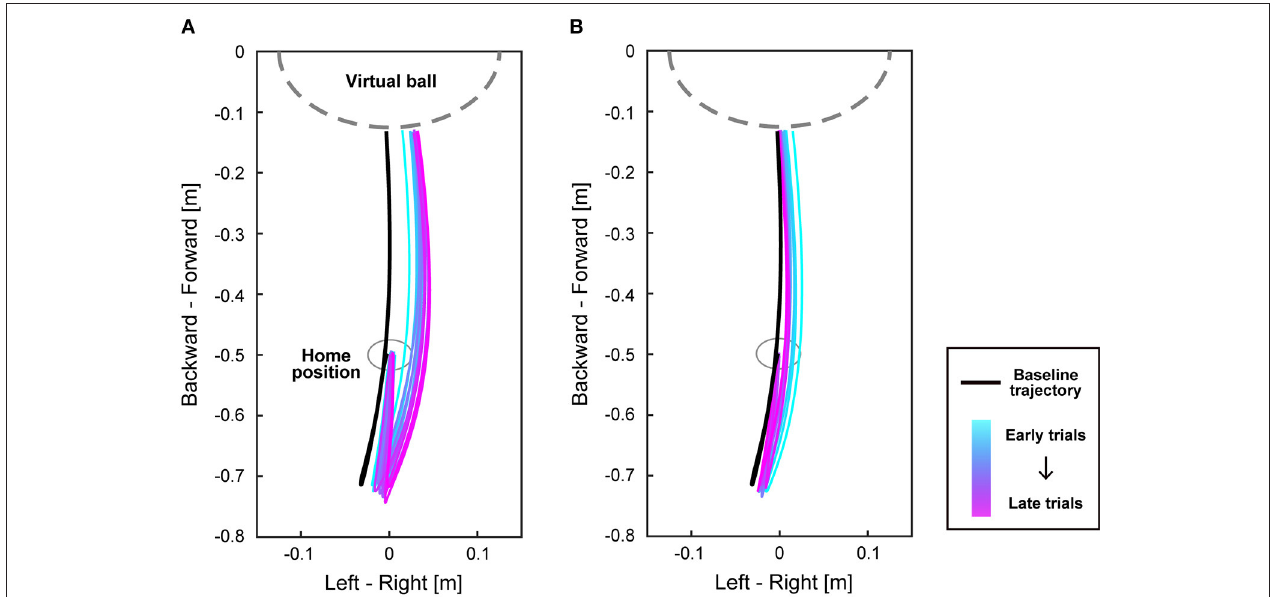
FIGURE 4 | Trajectories of the right foot during adaptation. (A,B) show the mean trajectories of the right foot on the horizontal plane from when participants started to move from the home position until their foot contacted the virtual ball. The black line represents the baseline trajectory of each group, and the colored lines show the mean trajectories of every 10 trials during the perturbation period (A) and the washout period (B) in the clockwise perturbation group. As the trials proceed, the color of the trajectory changes from cyan to magenta. The gray dashed line represents the location of a virtual